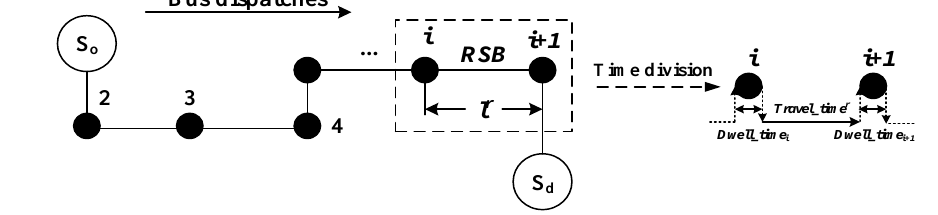
Figure 2. A general bus route.